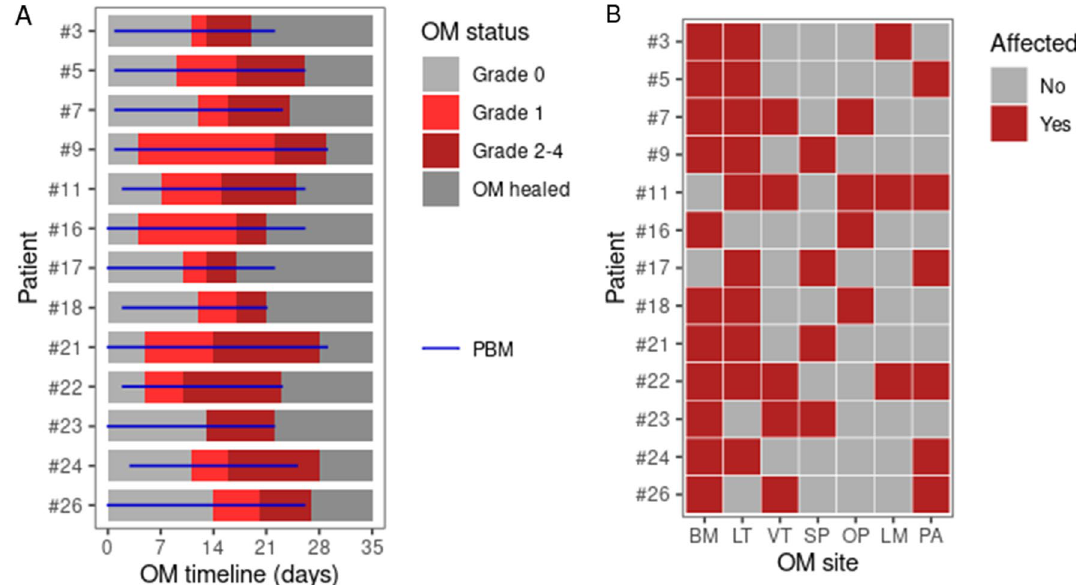
Figure 1. Oral mucositis (OM) timeline and sites affected by OM for each patient. ( A ) OM timeline in days for each OM patient. The OM grade along the timeline is indicated by a color scheme and the use of photobiomodulation (PBM) is indicated by a blue horizontal line. ( B ) Heatmap with the oral sites affected by OM for each patient. BM buccal mucosa, LT lateral tongue, VT ventral tongue, SP soft palate. OP oropharynx, LM labial mucosa, PA palatoglossal